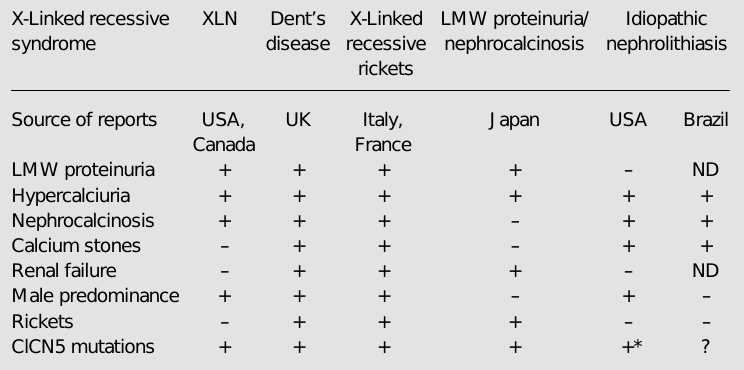
Table 1 - A summary of the main symptoms caused by the variants of X-linked hypercalciuric nephrolithiasis (XLN) and the symptoms detected in a study of idiopathic nephrolithiasis patients in the USA and Brazil (Refs. 5,60). Male predominance, hypercalciuria, and low molecular weight (LMW) proteinuria are present in all XLN patients. However, rickets, calcium stones, and renal failure vary among syndromes. Several mutations in ClCN5 are found in these syndromes. Never- theless, mutation in ClC-5 was detected in just one person among 32 patients with idiopathic hypercalciuric nephrolithiasis. No study addressing ClCN5 mutations or a characterization of a syndrome closely related to Dent’s disease is available for the Brazilian patients. ND, Not determined. (Modified from Ref. 17, with permission). *Found in just one patient (Ref.